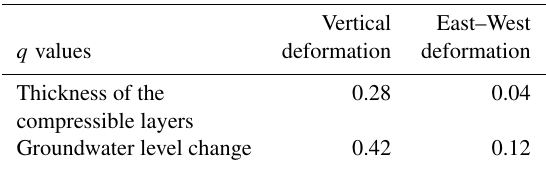
Table 2. Degree of influence of the thickness of the compressible layers and groundwater level change in confined aquifers on the vertical and the East–West deformation.